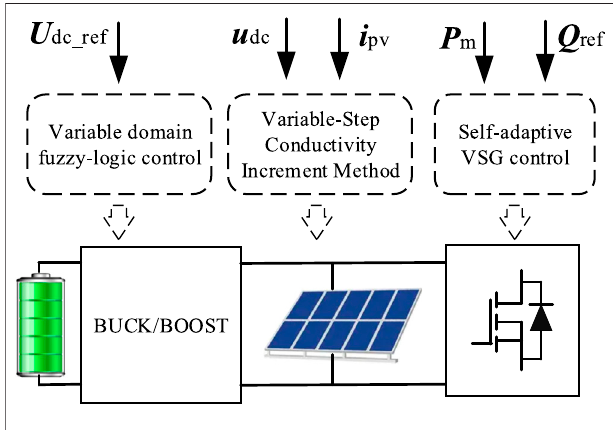
FIGURE 6 | Coordinated control for the system.